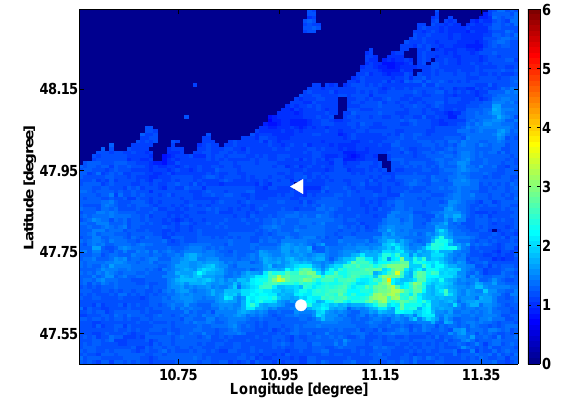
Fig. 6. Copula maps for stations Garmisch-Partenkirchen (top) and Fig. 6: Copula maps for stations Garmisch-Partenkirchen Wielenbach (bottom) showing the parameter θ of the Gumbel- (top) and Wielenbach (bottom) showing the parameter θ Hougaard copula. The position of Hohenpeissenberg is indicated by of the Gumbel-Hougaard Copula. The position of Ho- a white triangle, Garmisch-Partenkirchen (in the south) and Wielen- bach (in the north) by a white circle.